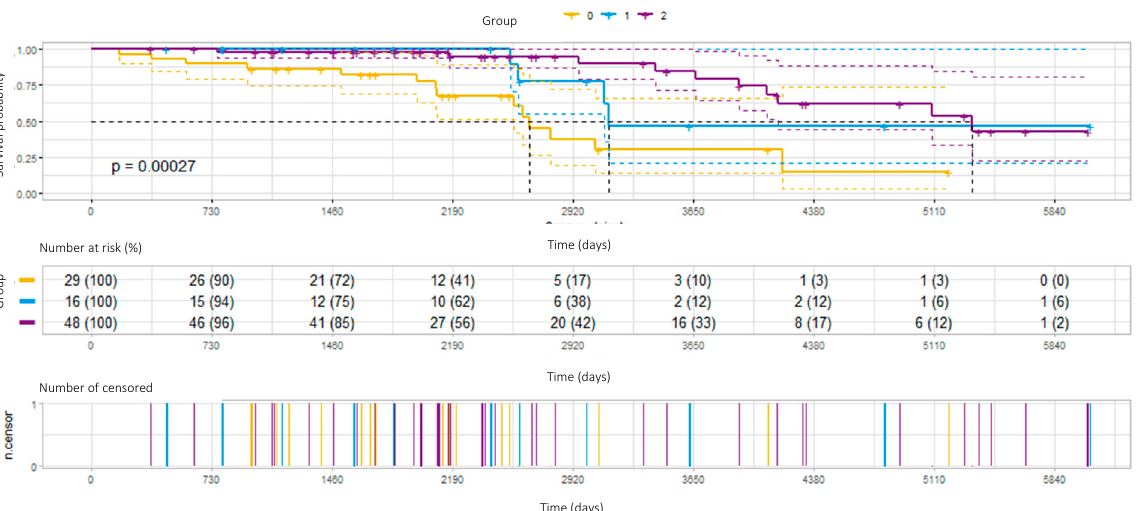
Response to treatment or stabilization during therapy was combined with a 243 significant survival advantage (Figure 2). Median survival times in the patients who 244 responded to treatment, who were stable, or who progressed were: 178 months, 104 245 Fig. 5 Kaplan-Meier survival curves according to the fibrosis months, and 88 months, respectively (p=0.00027).